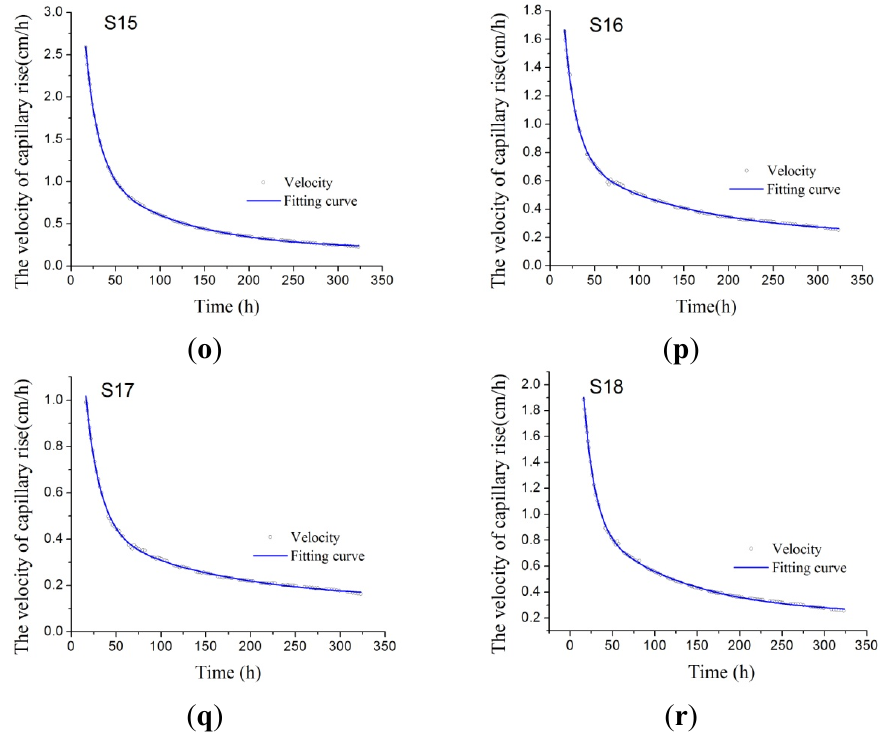
Figure 9. Velocity of capillary rise of 18 major soil types in the Sanjiang Plain, Northeast China. ( a ) S1; ( b ) S2; ( c ) S3; ( d ) S4; ( e ) S5; ( f ) S6; ( g ) S7; ( h ) S8; ( i ) S9; ( j ) S10; ( k ) S11; ( l ) S12; ( m ) S13; ( n ) S14; ( o ) S15; ( p ) S16; ( q ) S17; ( r ) S18.